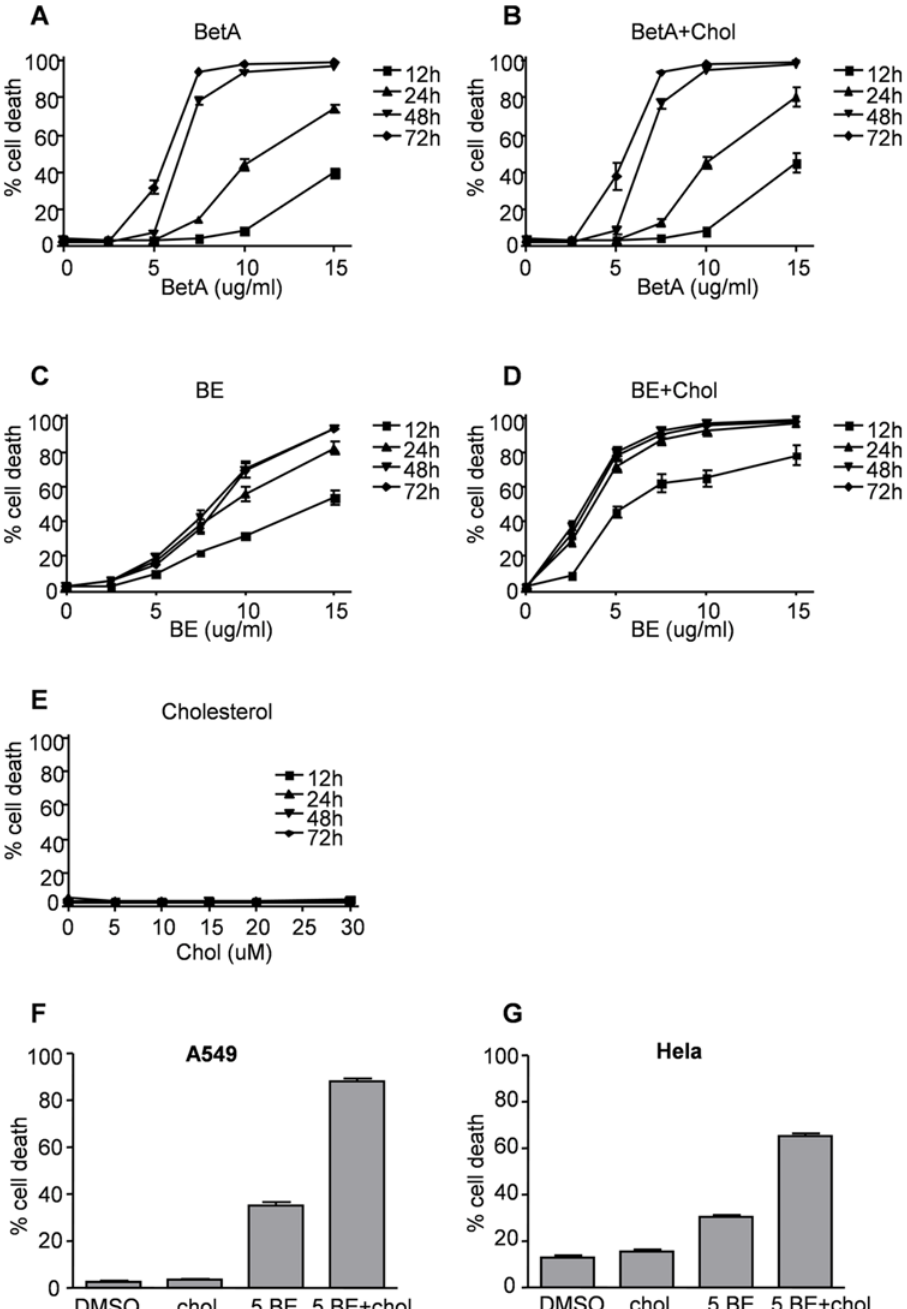
Figure 1. Cholesterol strongly enhances cytotoxic effects of BE but not BetA. Jurkat cells were treated with the indicated concentrations of BetA (A), BetA in combination with 5 m M cholesterol (B), BE (C), BE in combination with 5 m M cholesterol (D) or various concentrations of cholesterol only (E). Cell death was monitored after 12, 24, 48 and 72 hours using PI exclusion. A549 lung cancer (F) and HeLa cervix carcinoma (G) cell lines were treated with 5 m M cholesterol (chol), 5 m g/ml BE (5 BE) or the combination of 5 m g/ml BE with 5 m M cholesterol (5 BE + chol) and after 24 hours cell death was analyzed via PI exclusion.